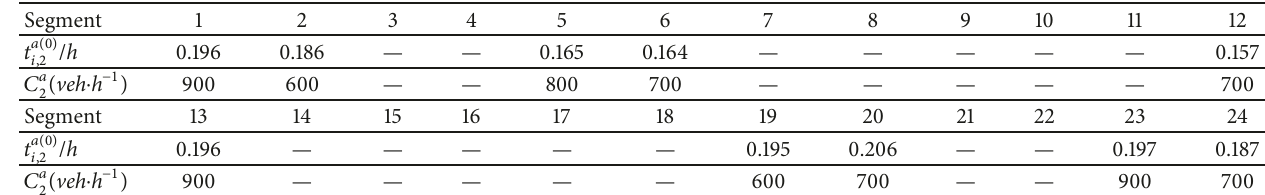
Table 1: Relevant data of the sample of public transport network.